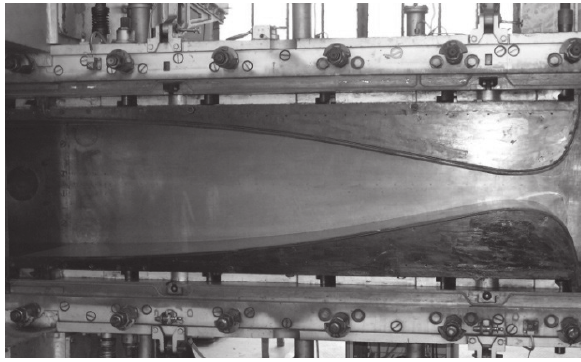
Figure 8. View of the WT nozzle inserts that helps maintain the Mach number M =